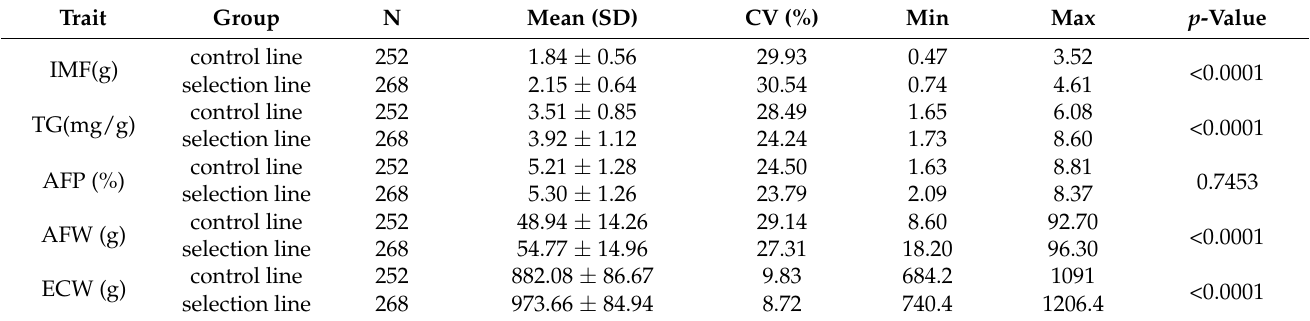
Table 1. Descriptive AFP, AFW, ECW statistics at different lines.